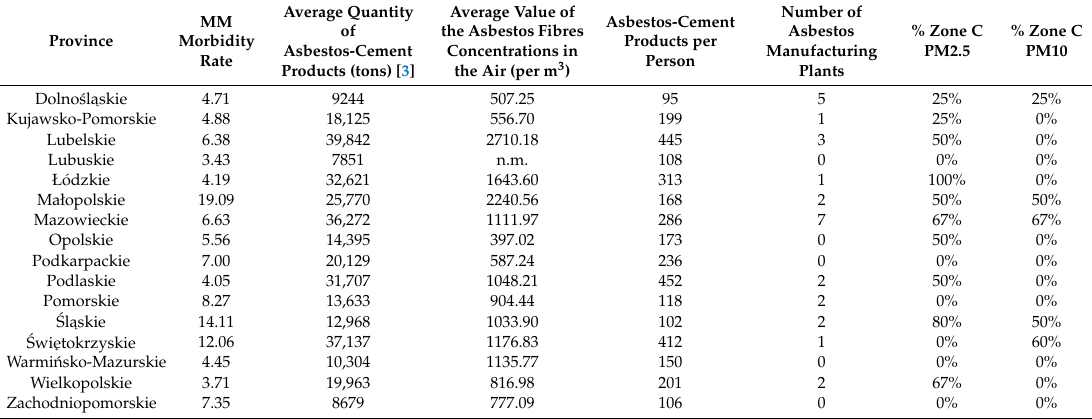
Table 1. MM morbidity rate in Poland in relation to the amount of asbestos-cement products, asbestos manufacturing plants and the air pollution